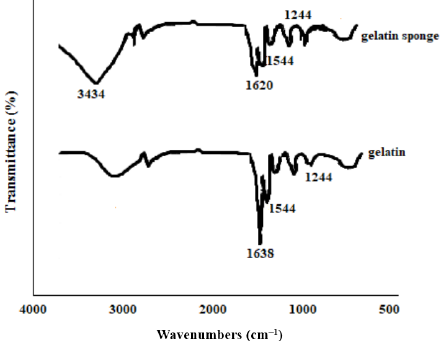
Figure 4. FTIR results for gelatin and the produced sponge.